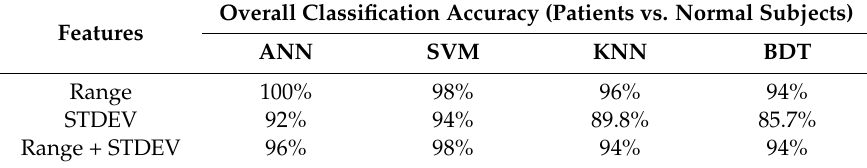
Table 7. Overall classification accuracy of different algorithms using different input features.